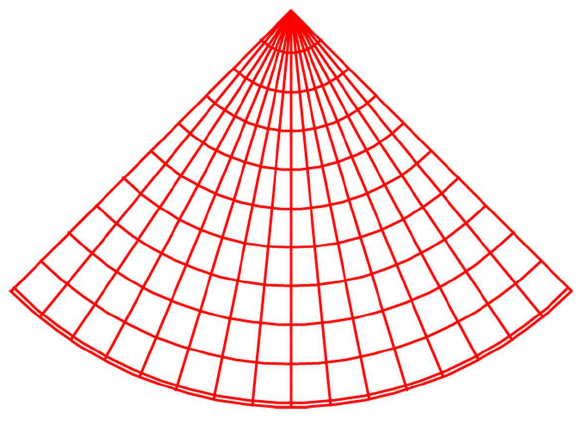
Figure 8. Development of the time